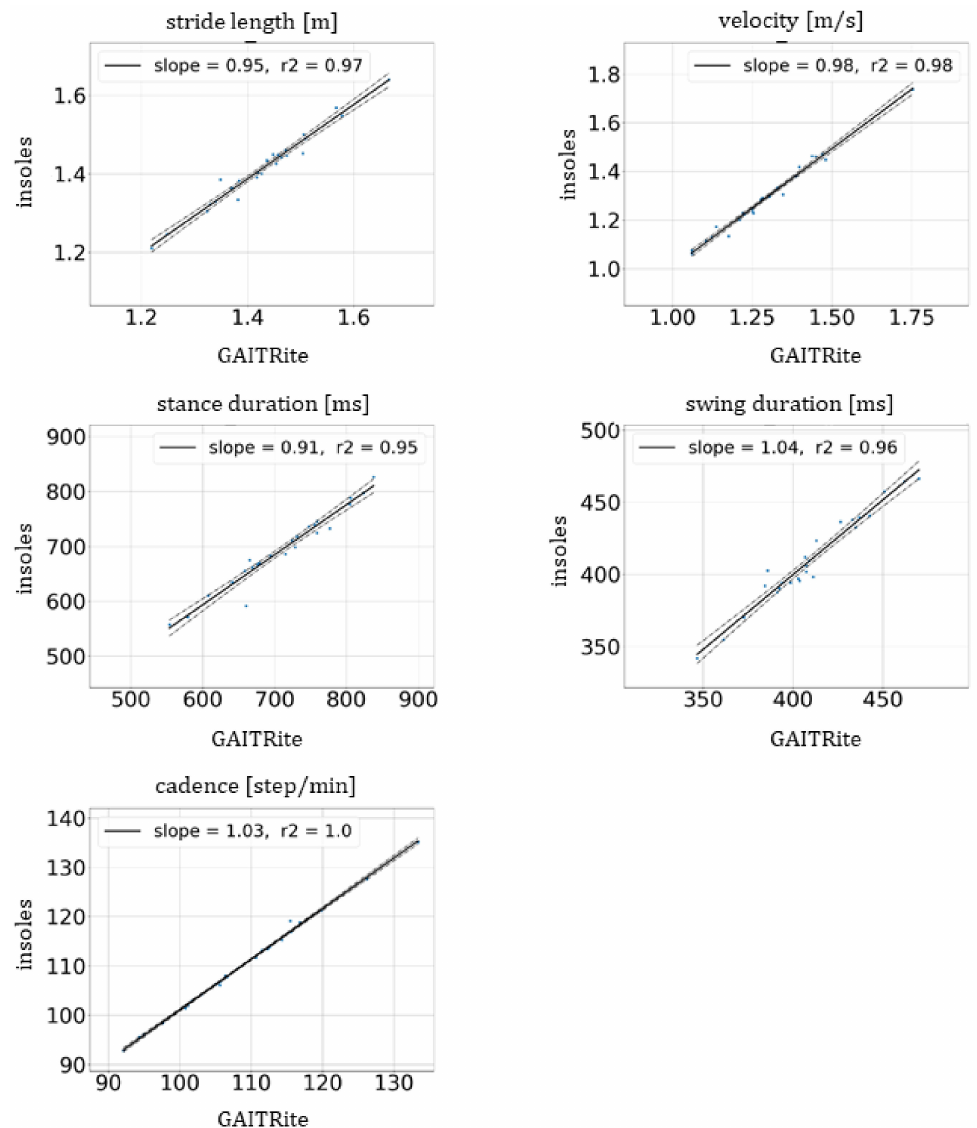
Figure 3. Linear regression of average estimates of unipedal gait parameters for velocity, stride length, stance and swing duration and cadence between GAITRite ® mat and the insoles (solid lines). The dashed lines represent the confidence region. The values of the slope and the coefficient of determination, r 2 , are provided in the